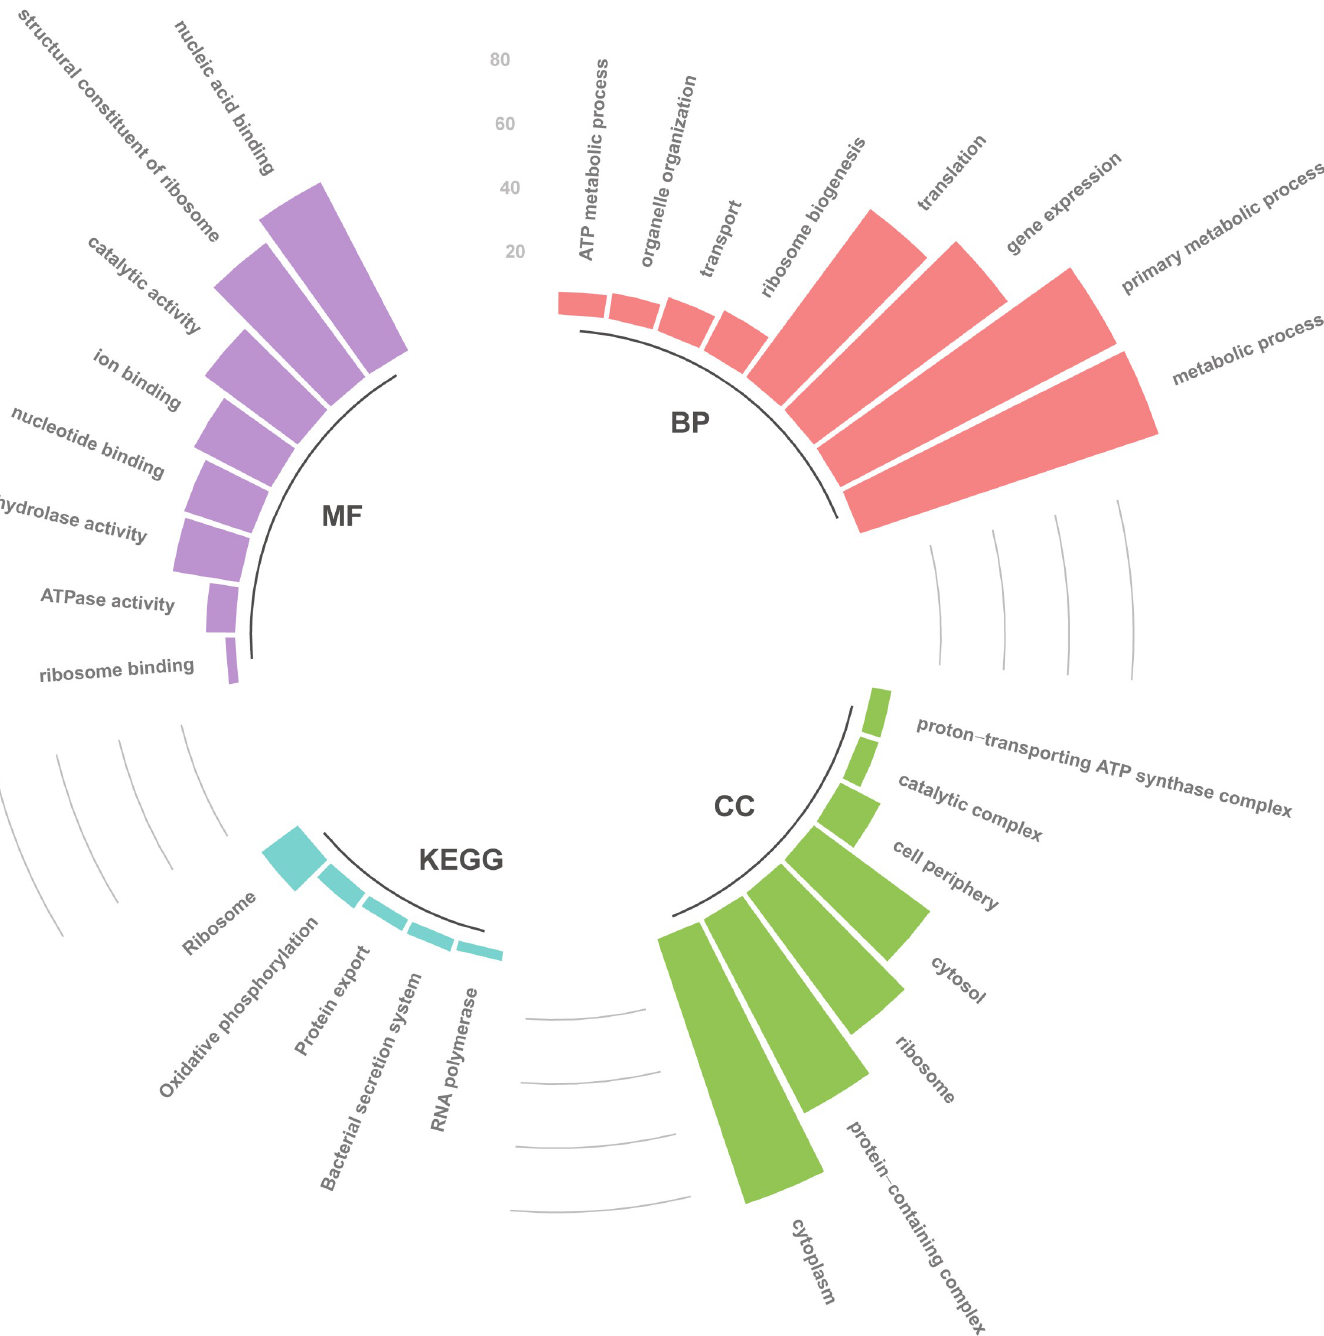
Fig 7. Functional enrichment analysis of the benzylpenicillin network in Staphylococcus aureus based on Gene Ontology (GO) and Kyoto Encyclopedia of Genes and Genomes (KEGG) pathways. The network contains the 4 discriminant proteins, that were found to be discriminant between benzylpenicillin resistant and susceptible isolates, and their 149 first neighbours. GO consists of cellular component (CC), molecular function (MF) and biological process (BP). In each ontology, the enriched categories and the number of genes populating them are shown. Likewise, the enriched KEGG pathways and the number of genes populating each pathway are